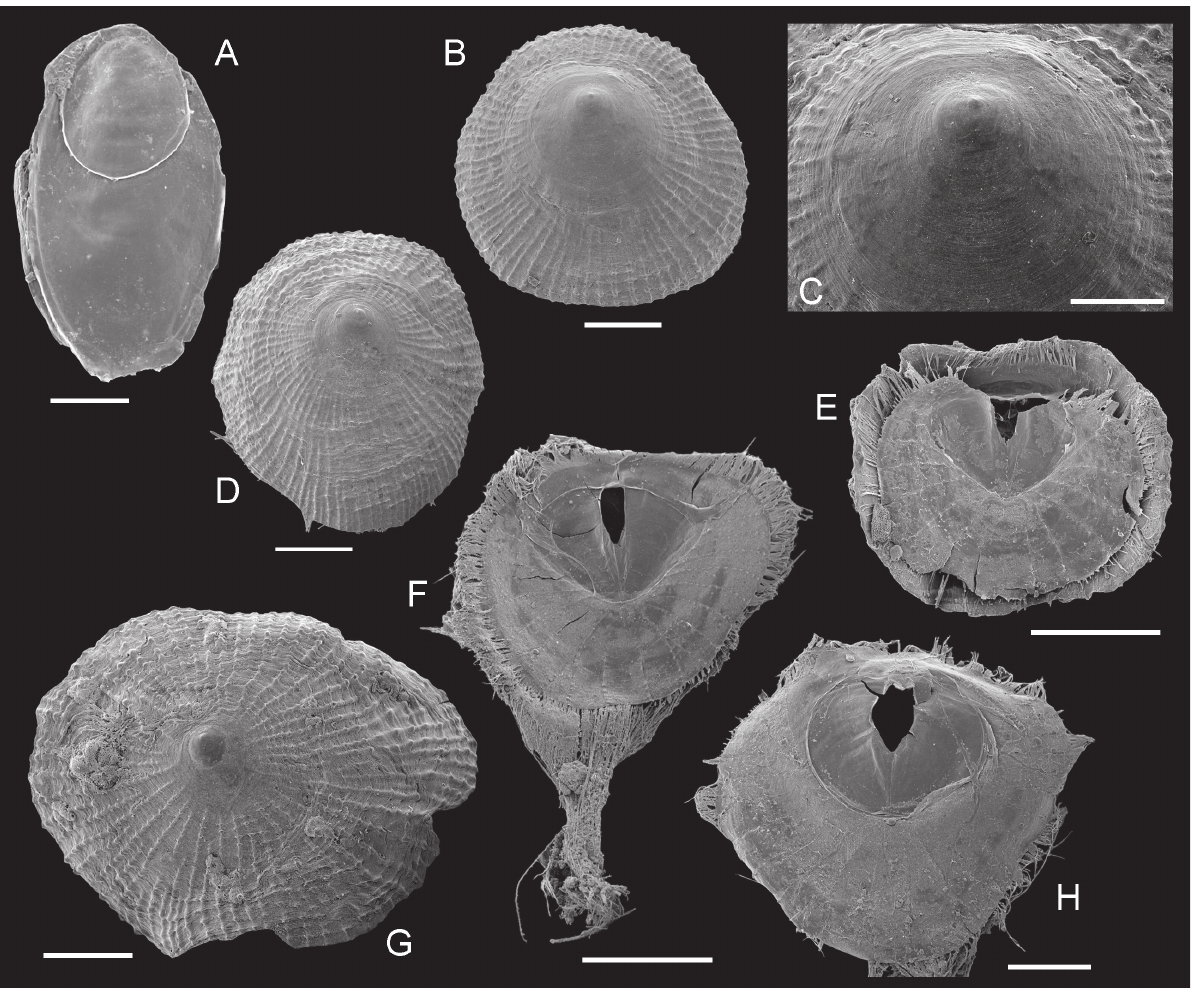
Fig . 2. – a, Lingula sp., damaged valve from Persian gulf, Jana island, sample Pg95-42, 16 m, sMF 869 01; B-h, Discradisca indica (dall, 1920); B, c, exterior view of dorsal valve and enlargement (c) of the apex, sample k119, 27.5 m, ZPal Bp.61/1; d, dorsal view of complete specimen, sample k119, 27.5 m, ZPal Bp.61/2; e, F, ventral views of complete specimens showing large subcircular peduncular area, sample k119, 27.5 m, ZPal Bp.61/3-4; g, exterior view of dorsal valve, karan island, sample Pg95-40, 12 m, sMF 869 02; h, exterior view of ventral valve, sample k119, 27.5 m, ZPal Bp.61/5. all seM. scale bars: a, c, 500 µm; B, d, e, g, h, 1 mm; F, 2